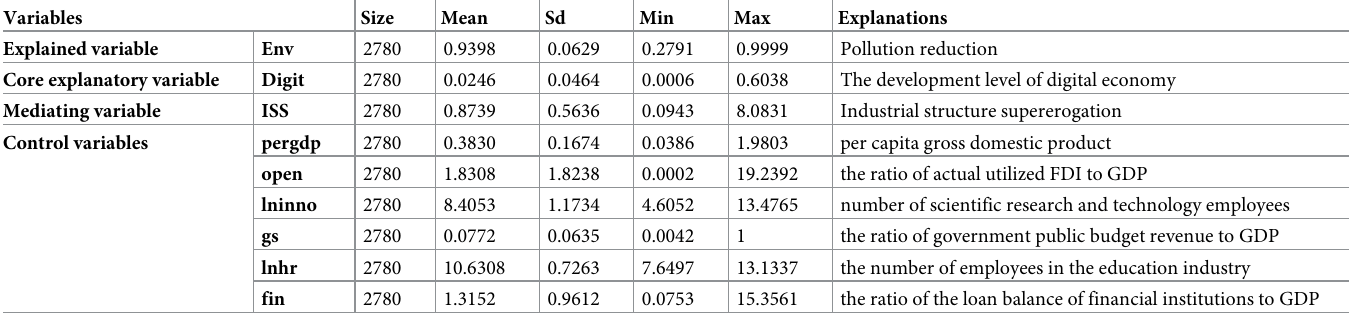
Table 2. Descriptive statistics of the variables.